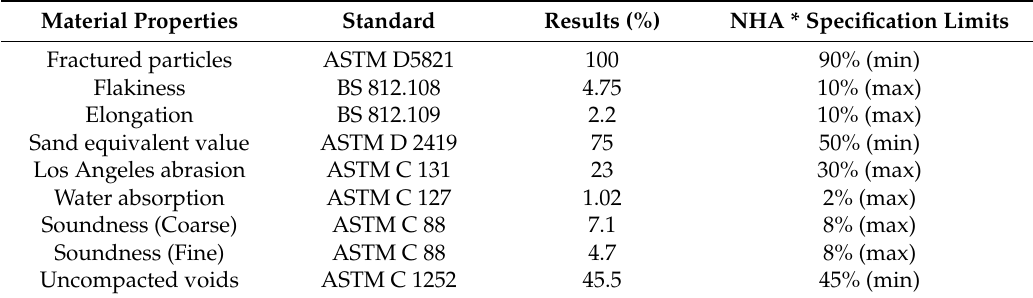
Table 2. The properties of the aggregates procured from Margalla